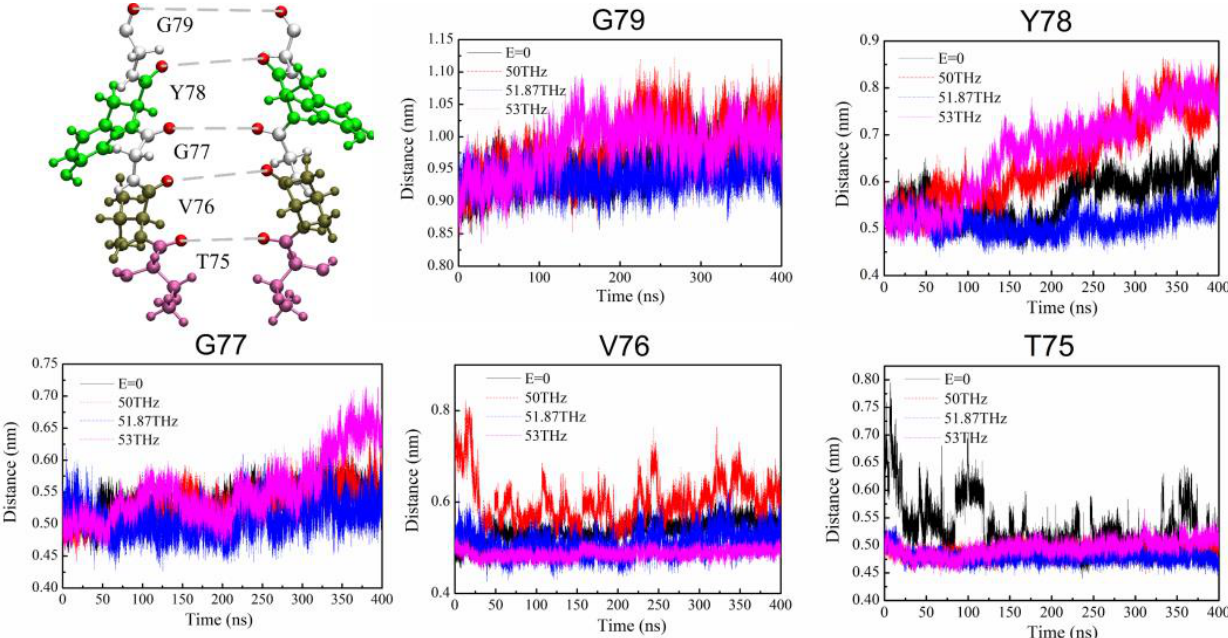
Figure 6. The average distance ( l ) over time between the carbonyl oxygen atom on each residue and the carbonyl oxygen atom on the symmetric residue in the SF. Pore radius ( r ) is equal to l /2 minus oxygen atom radius (r o ).